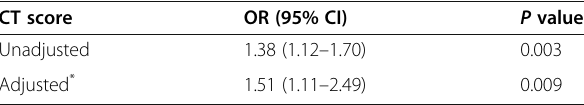
Table 3 Adjusted and unadjusted relationships between the CT score and the